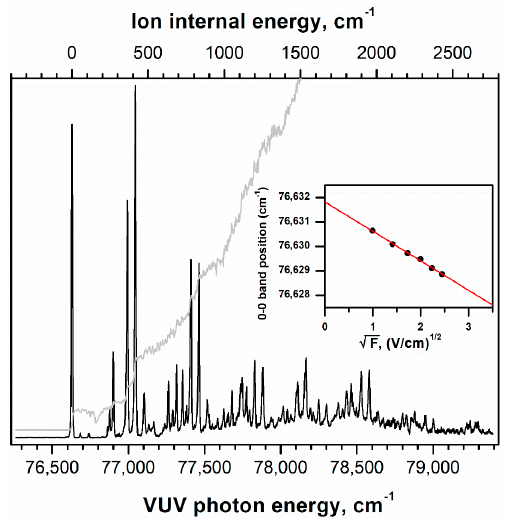
Figure 1. Delayed VUV–PIE curve (solid-gray line) for the C 5 H 10 O +• signal measured as a function of photon energy of VUV laser pulse at the bottom horizontal axis. Based on the onset observed in the PIE curve, the HR VUV-MATI spectrum of pivaldehyde was recorded, where the 0–0 band position was located at 76,629 cm − 1 . Ion internal energy at the top horizontal axis corresponds to cationic vibrational frequency, estimated by setting the 0–0 band position as the origin. Inset: AIE of pivaldehyde determined accurately by extrapolating the 0–0 band position in the MATI spectrum to the zero-field limit.